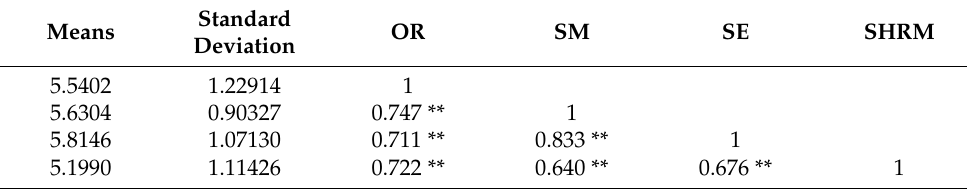
Table 3. Means, variances, and correlation coefficients of the